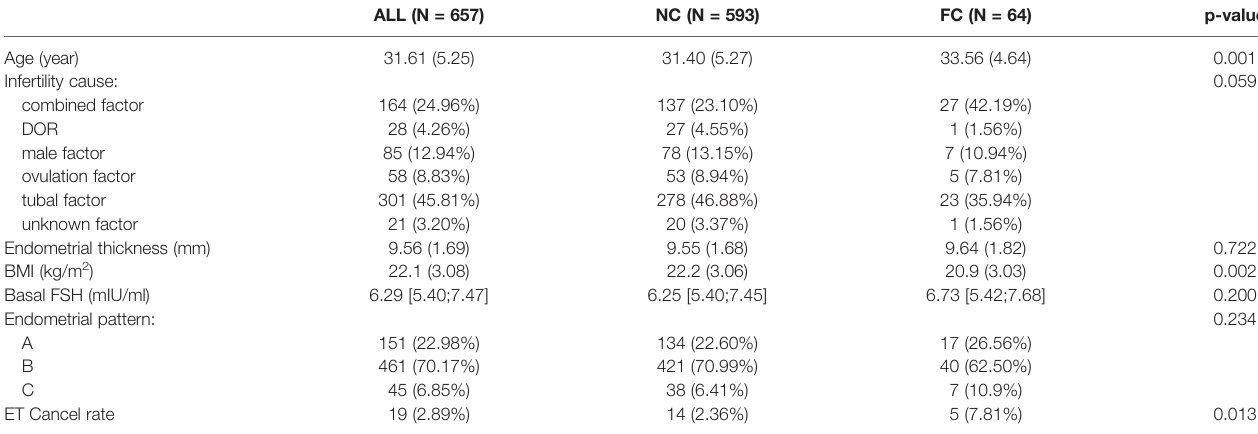
TABLE 1 | Patients ’ characteristics of the crude